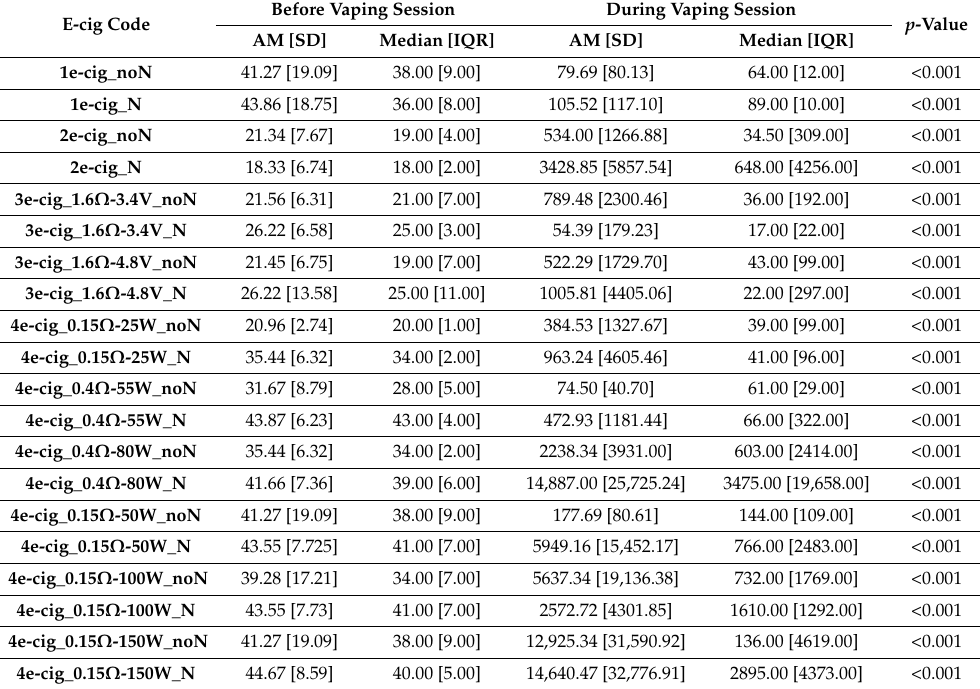
Table 2. Summary statistics of PM 1 concentrations ( µ g m − 3 ) before and during the vaping session for each test. Table2. Summary statistics of PM 1 concentrations ( μg m − 3 ) before and during the vaping session for each test.